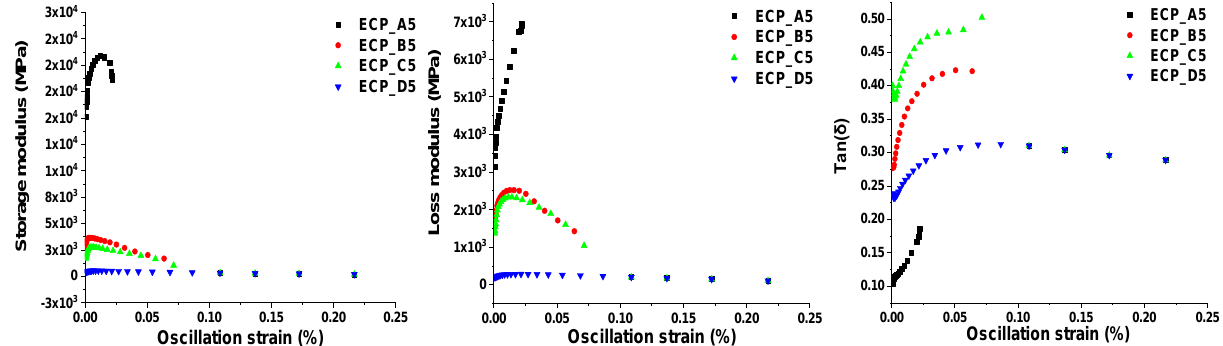
Figure 10. Bending behavior of the composite rocket propellants.